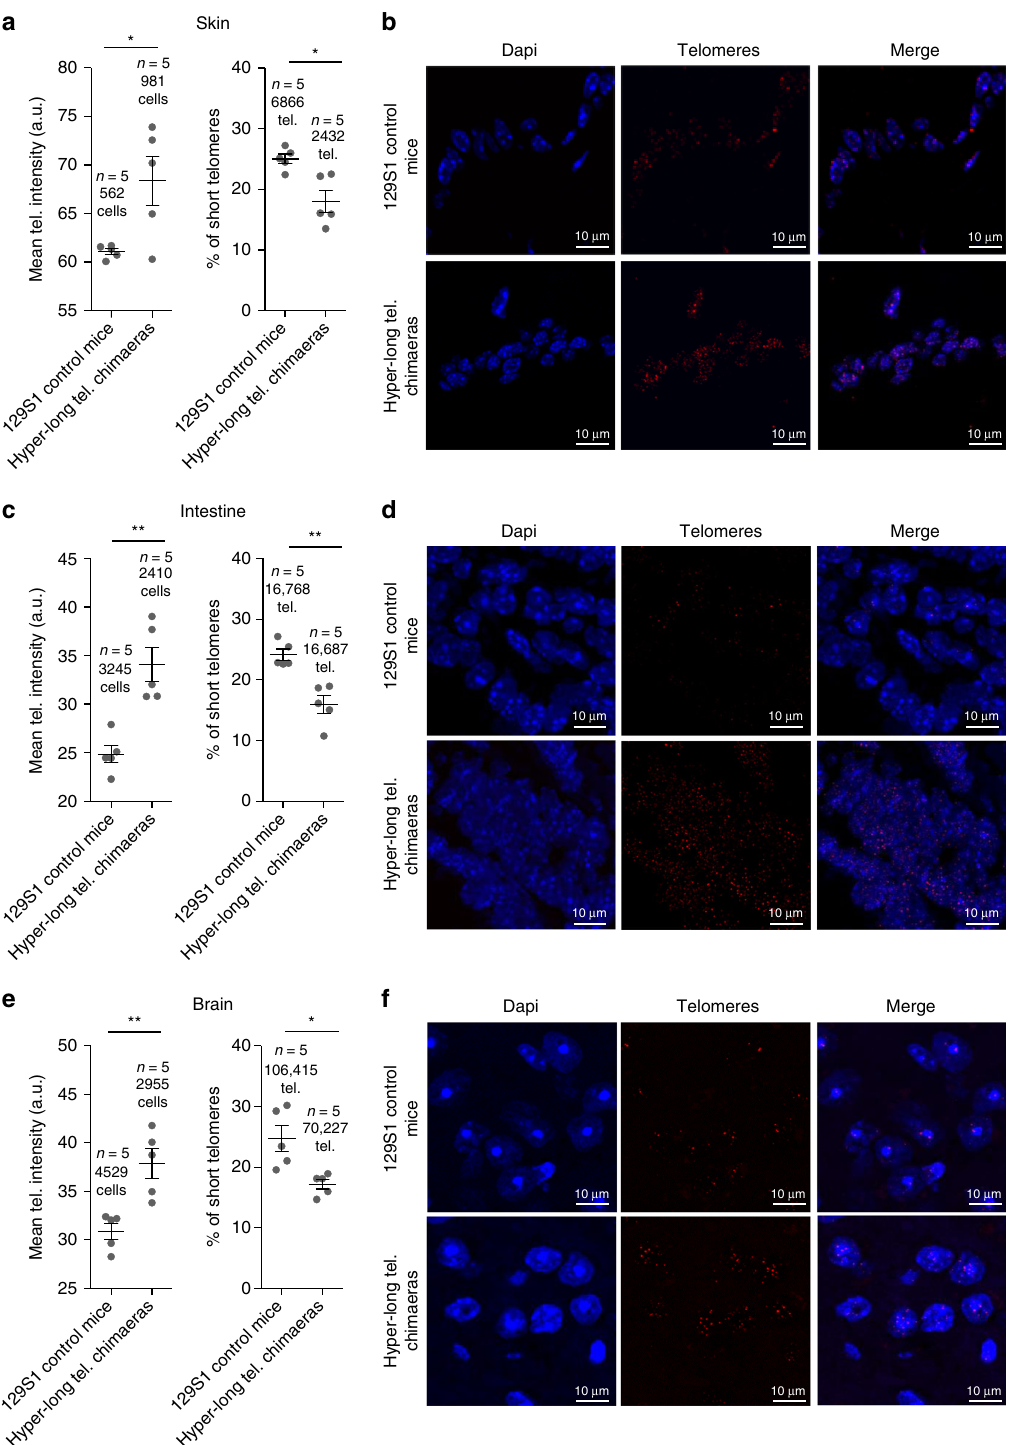
Fig. 5 Hyper-long telomere mice show longer telomeres throughout their lifespan in both proliferative and non-proliferative tissues. a – f Mean telomere fl uorescence and percentage of short telomeres in back skin ( a , b ), intestine ( c , d ), brain ( e , f ) in 100 weeks-old hyper-long telomere mice and age- matched controls. Error bars represent standard error. t -test was used for statistical analysis. The number of mice is indicated in each case. * p < 0.05. ** p < 0.01. *** p < 0.001. Source data are provided as a Source Data fi le